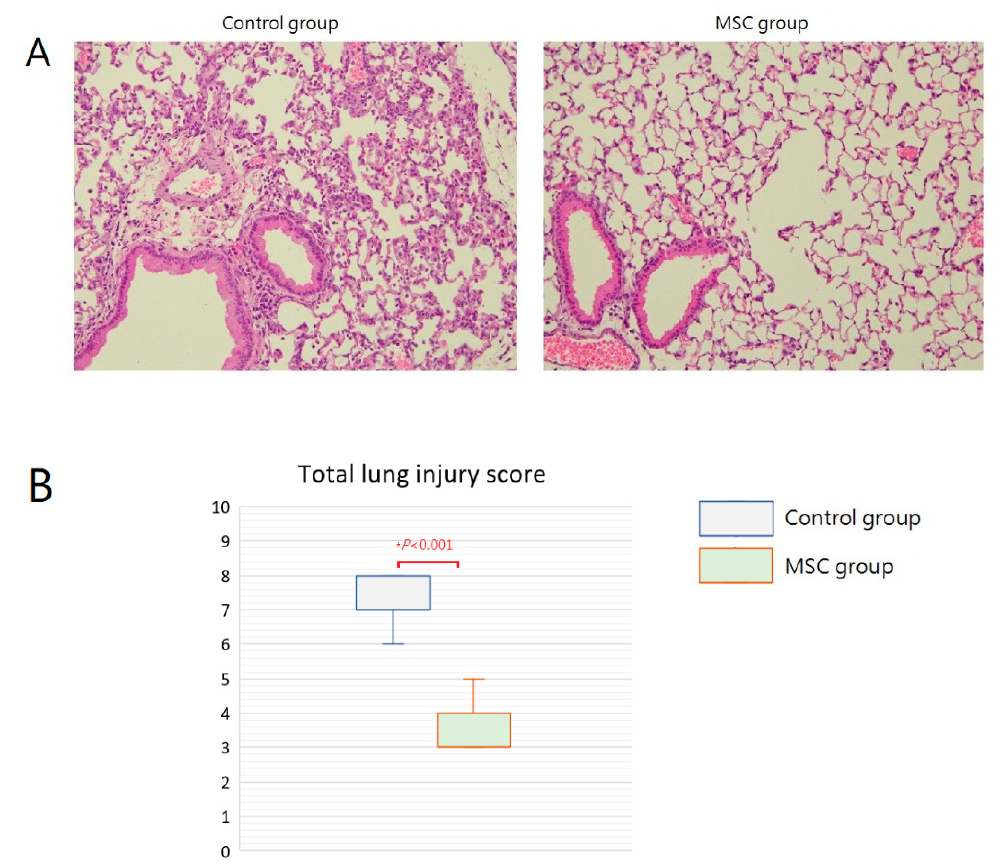
Figure 4. Effects of MSC administration on morphology of the lungs at 48 h after LPS-induced ALI. ( A ) Microscopic histopathology of the lung tissue (hematoxylin and eosin, ×200). ( B ) Boxplots of total lung injury scores. There was a significant difference between the two groups. Table 1. Average lung injury score for each estimated feature.